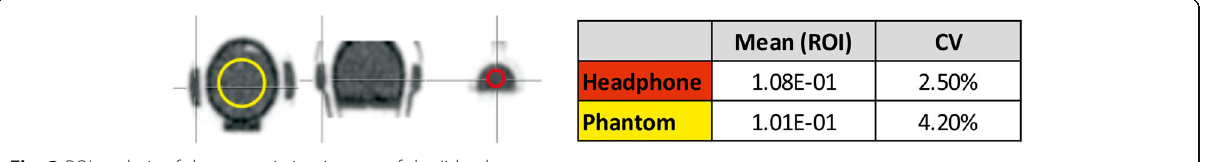
Fig. 3 ROI analysis of the transmission images of the Iida